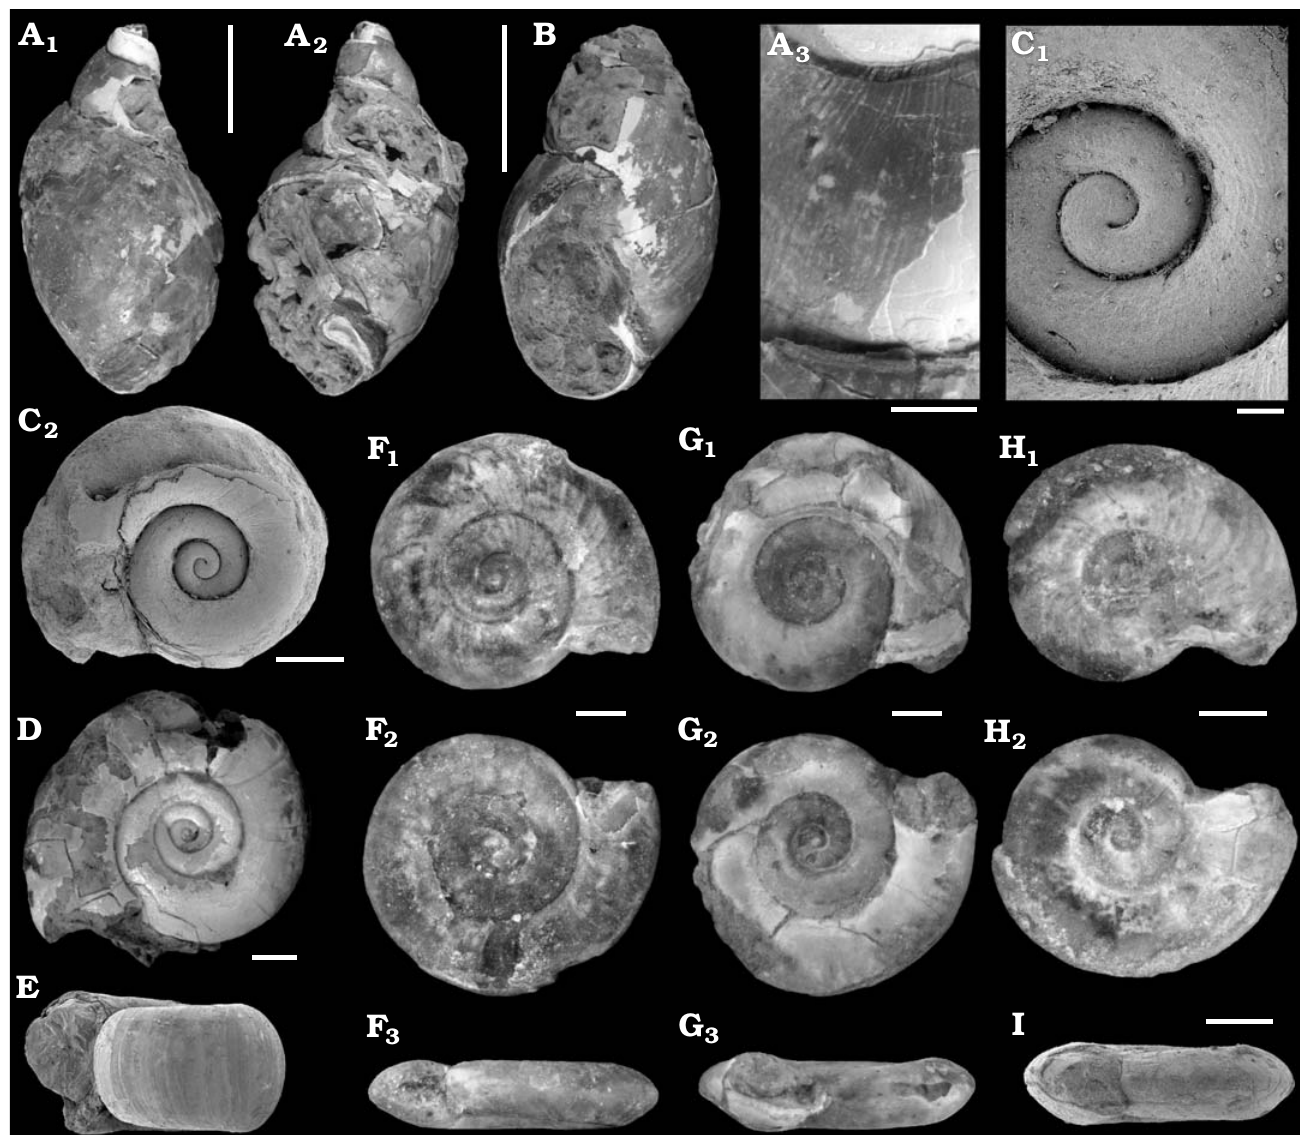
Fig. 5. Physid (A, B) and planorbid (C–I) gastropods from upper Oligocene–lower Miocene Susuz Formation, Kömürlü, Turkey. A , B . Aplexa cf. sub-